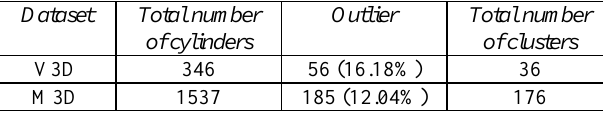
Table 4. Results of the clustering and outlier